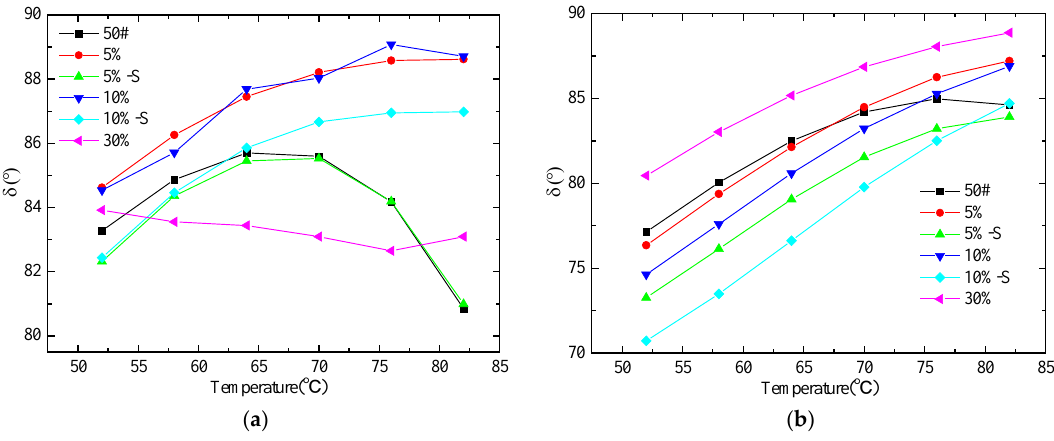
Figure 7. The relationship between phase angle and temperature. ( a ) Unaged; ( b ) RTFO aged.